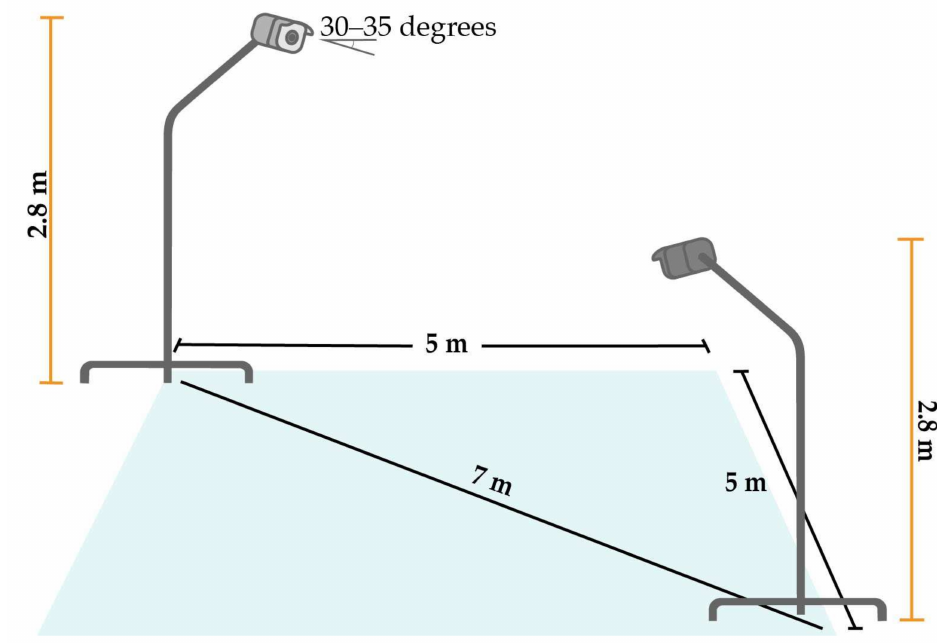
Figure 3. CCTV camera